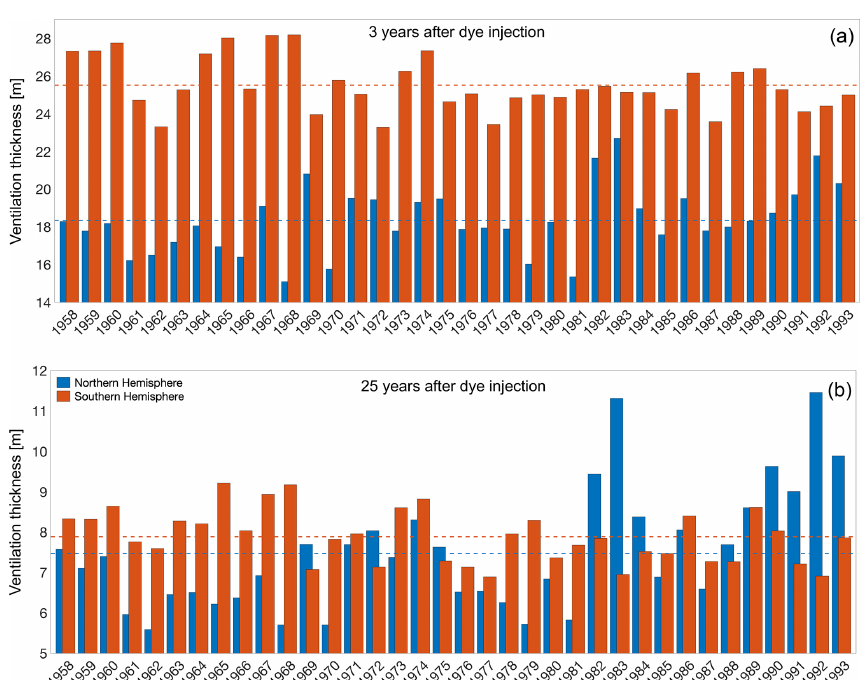
Figure 9. Ventilation thickness for both hemispheres for the same 36 dyes shown in Fig. 8 for 3 years (a) and 25 years (b) after injection. Note that the scale is different in the two panels, and it does not start from